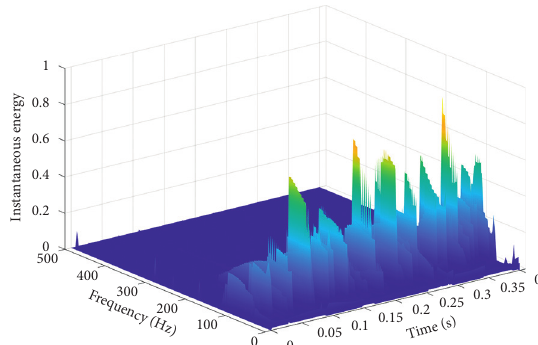
Figure 13: Hilbert spectrum of